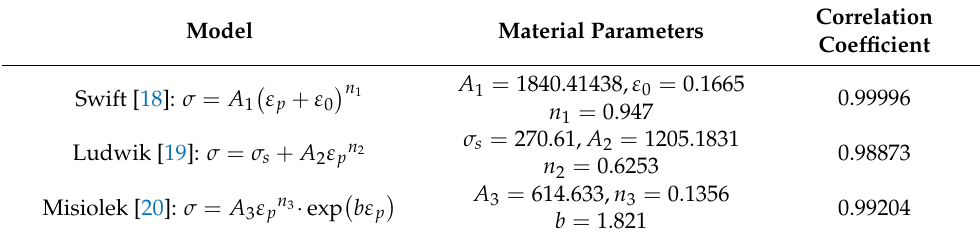
Figure 2. Fitting results of different flow stress mathematical models. Table 2. Calibration results of different flow stress mathematical models. Model Material Parameters